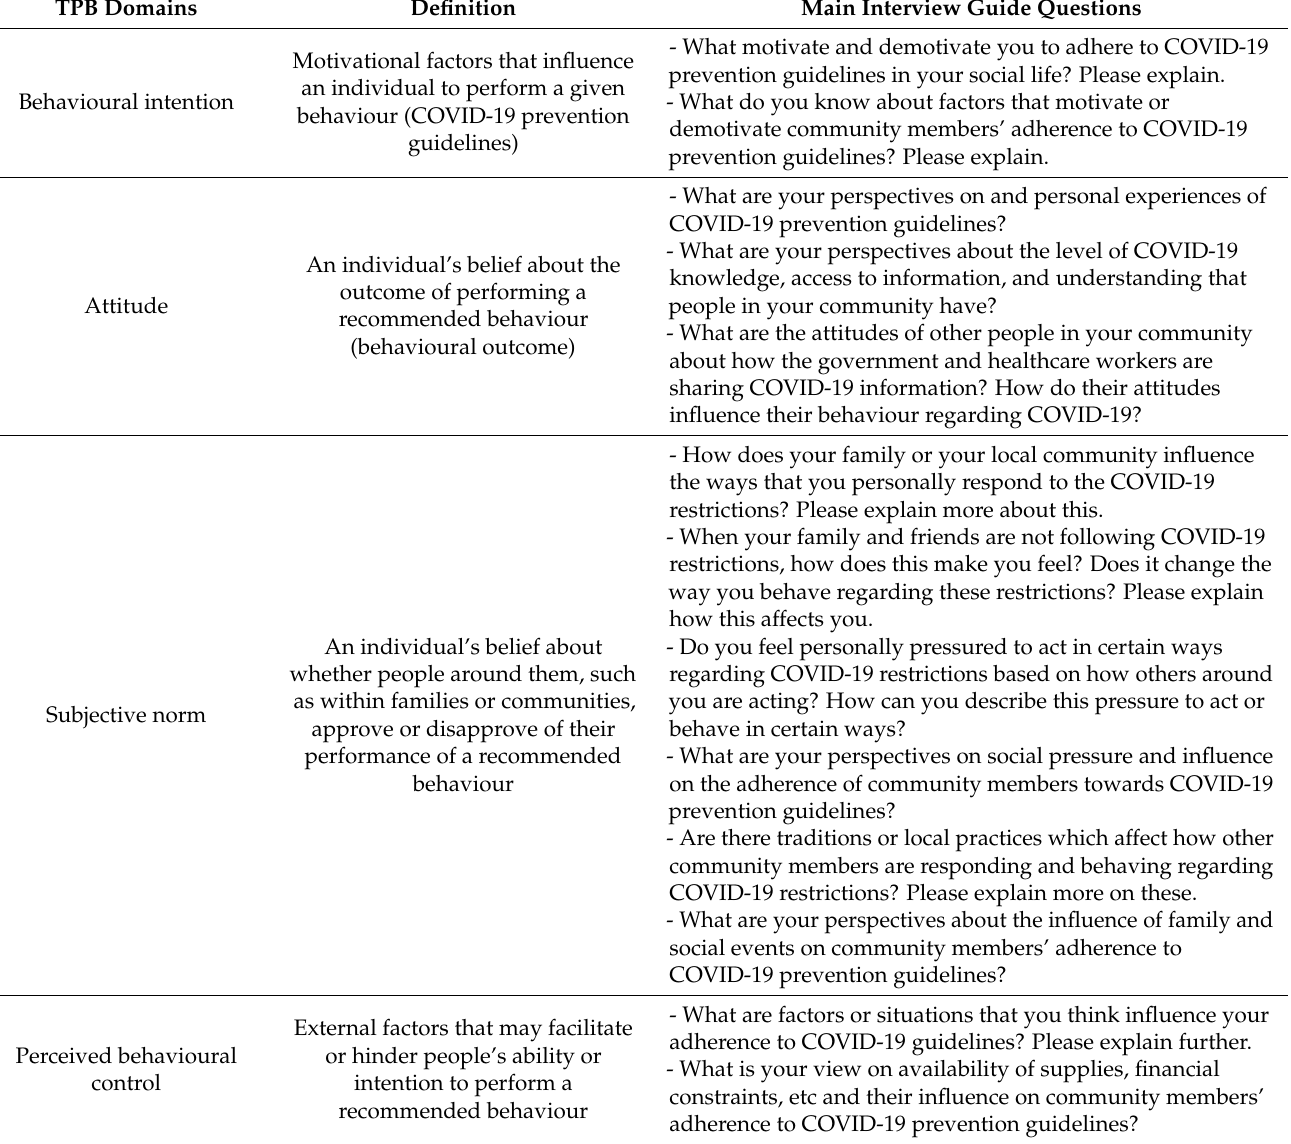
Table 1. Main interview guide questions based on TPB